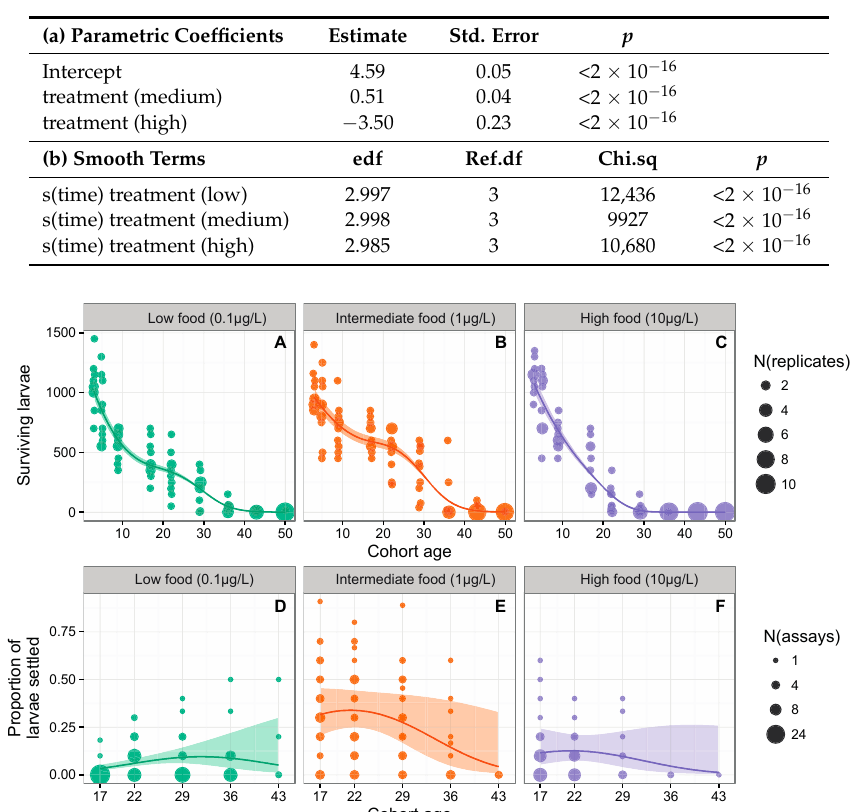
Figure 1. Non-linear effects of increasing food availability on larval survivorship and settlement for crown-of-thorns starfish ( Acanthaster cf. solaris ) from Australia’s Great Barrier Reef: ( A – C ) Absolute larval survivorship between 1 and 50 days post-fertilization for each of ten replicate cultures maintained at low (0.1 µ g · L − 1 ), medium (1.0 µ g · L − 1 ) or high (10 µ g · L − 1 ) chlorophyll